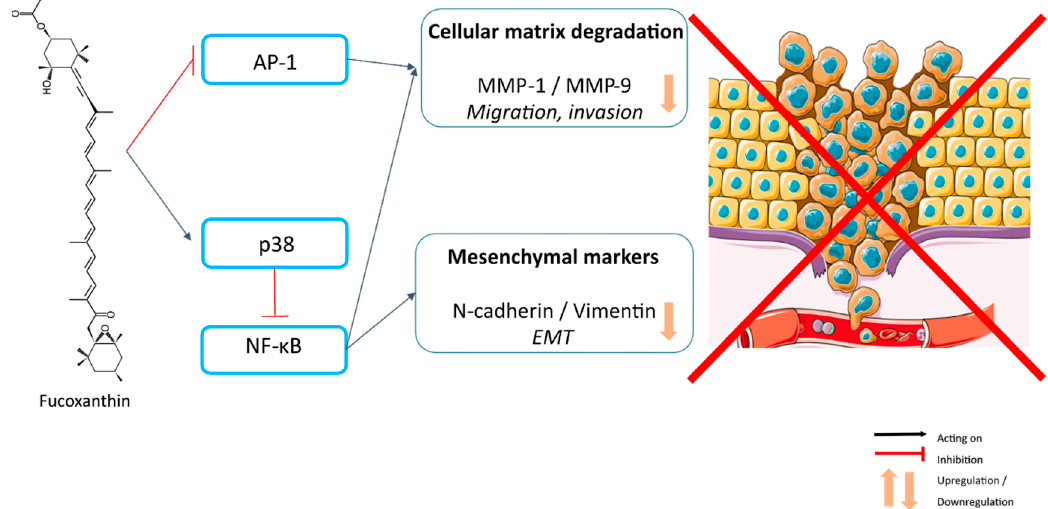
Figure 7. Inhibition of metastasis-related migration, invasion, and epithelial–mesenchymal transition by fucoxanthin. by